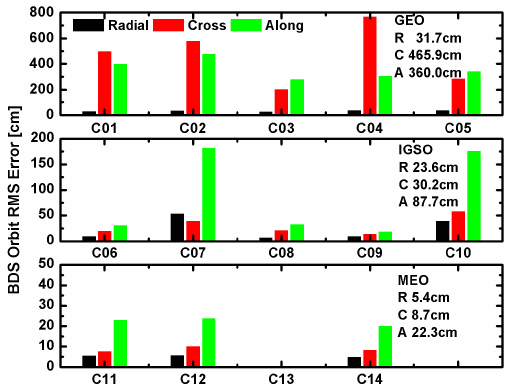
Figure 5. BDS orbit RMS compared with GFZ orbit products.